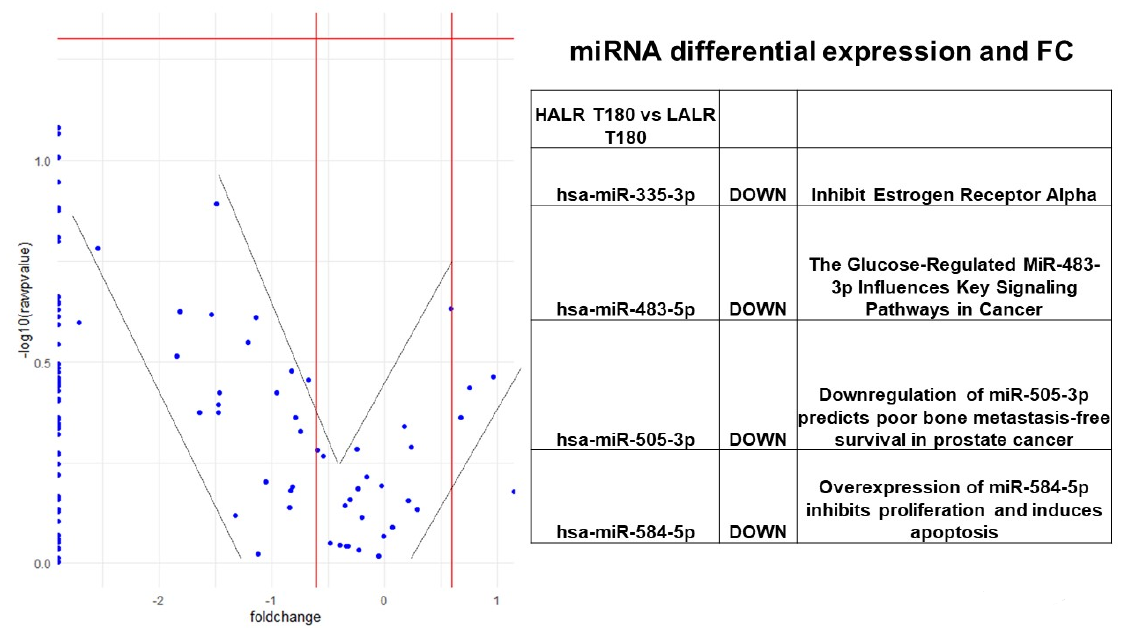
Figure 5. Volcano plot with differences in miRNA signatures for Time 180 ′ (peak of postprandial response) after a mixed meal among participants with (H) vs. (L)ALR.